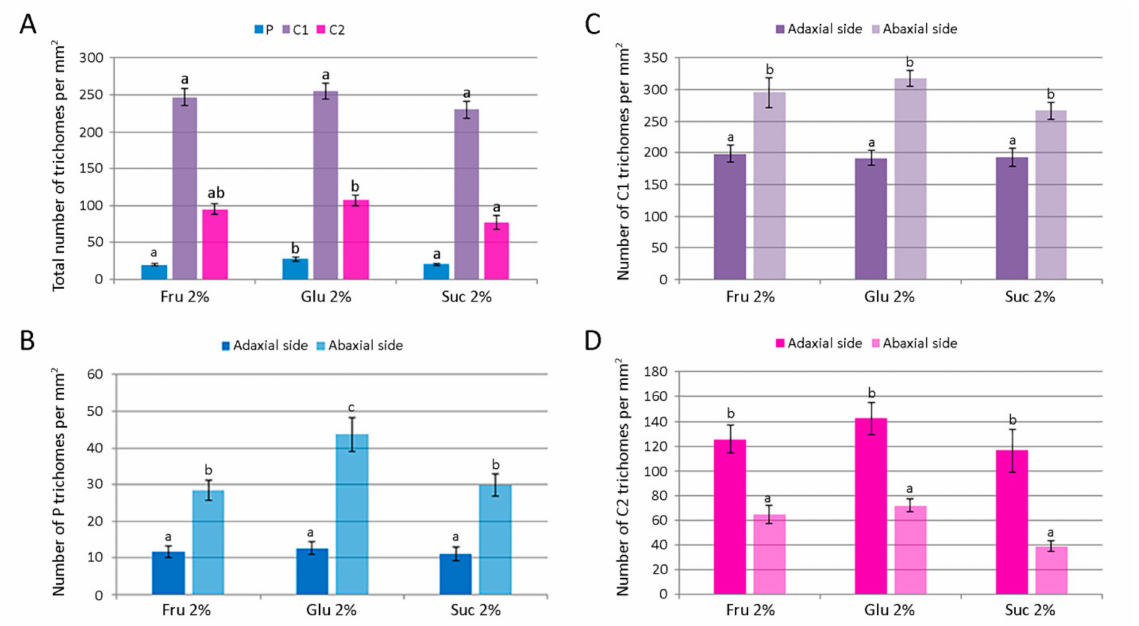
Figure 8. The number of glandular trichomes per unit area of leaves of Clinopodium pulegium plants cultured in vitro on medium supplemented with different carbohydrates at the concentration of 2%. ( A ) Overall density of different trichome morphotypes on both epidermis surfaces. ( B – D ) Distribution and density of peltate ( B ), type I capitate ( C ) and type II capitate ( D ) trichomes. Values represent means ± SE, n = 24. Means within the same histogram marked with different letters are significantly different according to Tukey’s HSD test at p ≤